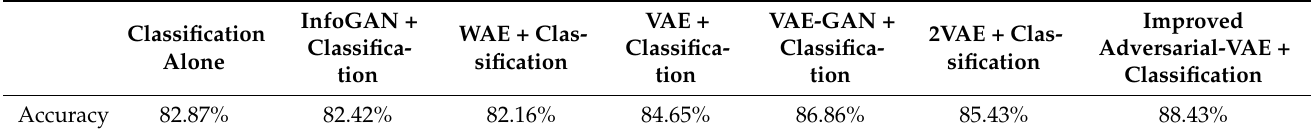
Table 8. Classification accuracy of the classification network trained with the expanded training set generated by different generative